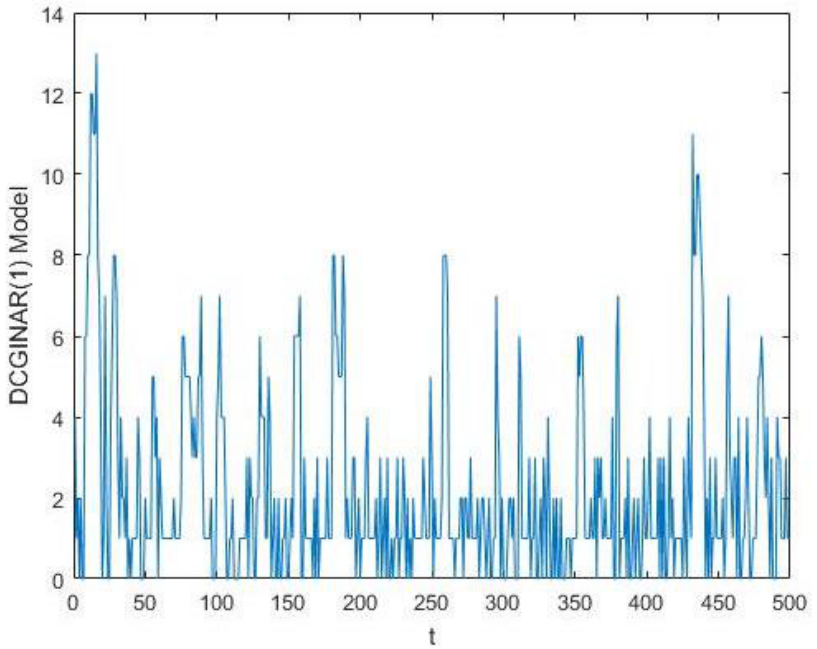
Figure 1. The simulated series of the DCGINAR(1) model at α = 0.6, θ = 0.7 and µ = 1.8.